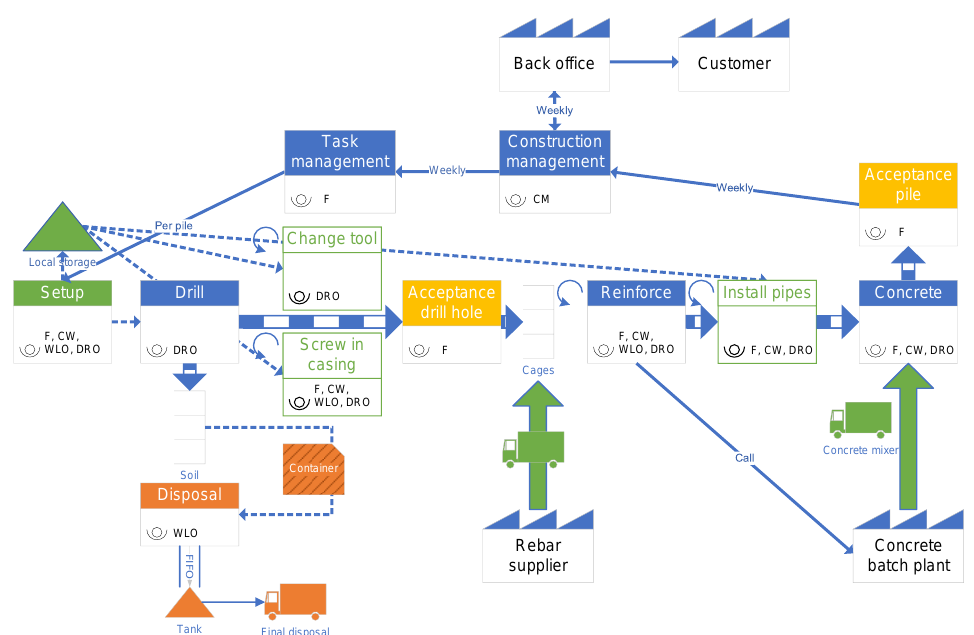
Figure 4. Value stream map for pile production using the Kelly drilling method [36] (blue: production; yellow: quality checks; green: procurement logistics; orange: disposal logistics) (CM: construction manager; F: foreman; CW: construction worker; DRO: drill rig operator; WLO: wheel loader operator)